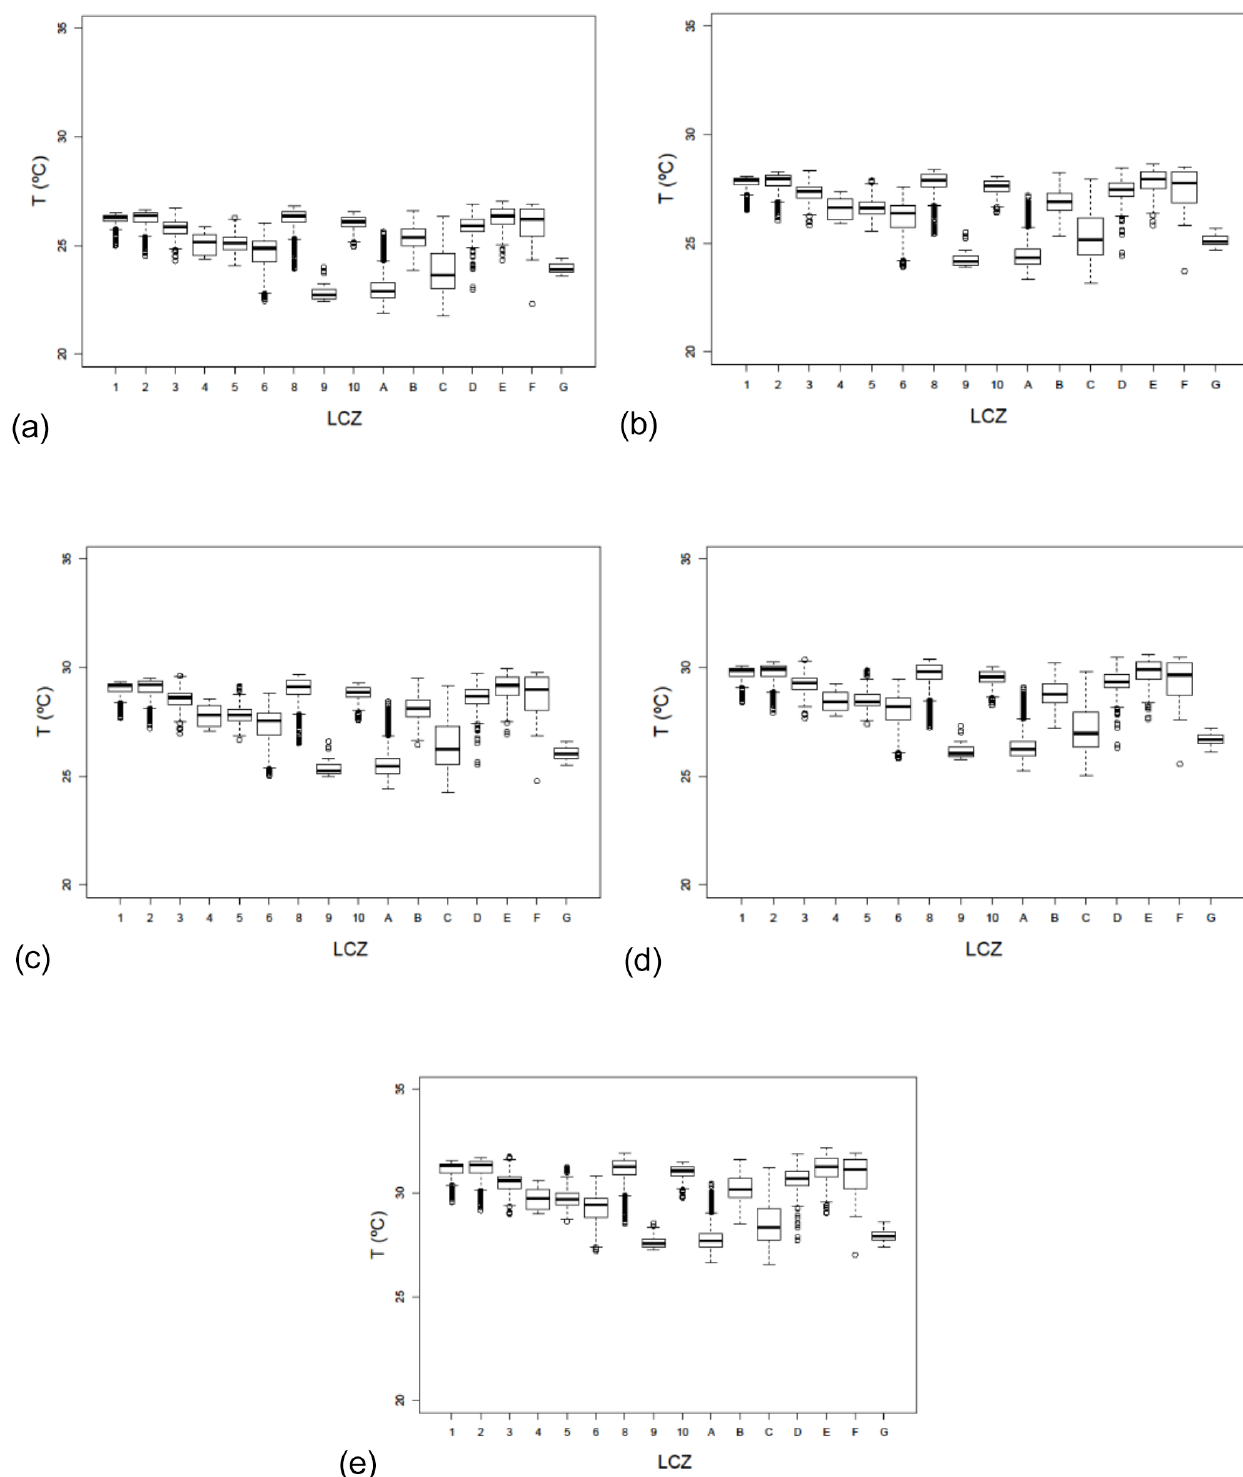
Figure 9. Box plots for the thermal characterisation of the LCZ for different distributions: (a) P50, (b) P75, (c) P90, (d) P95 and (e)